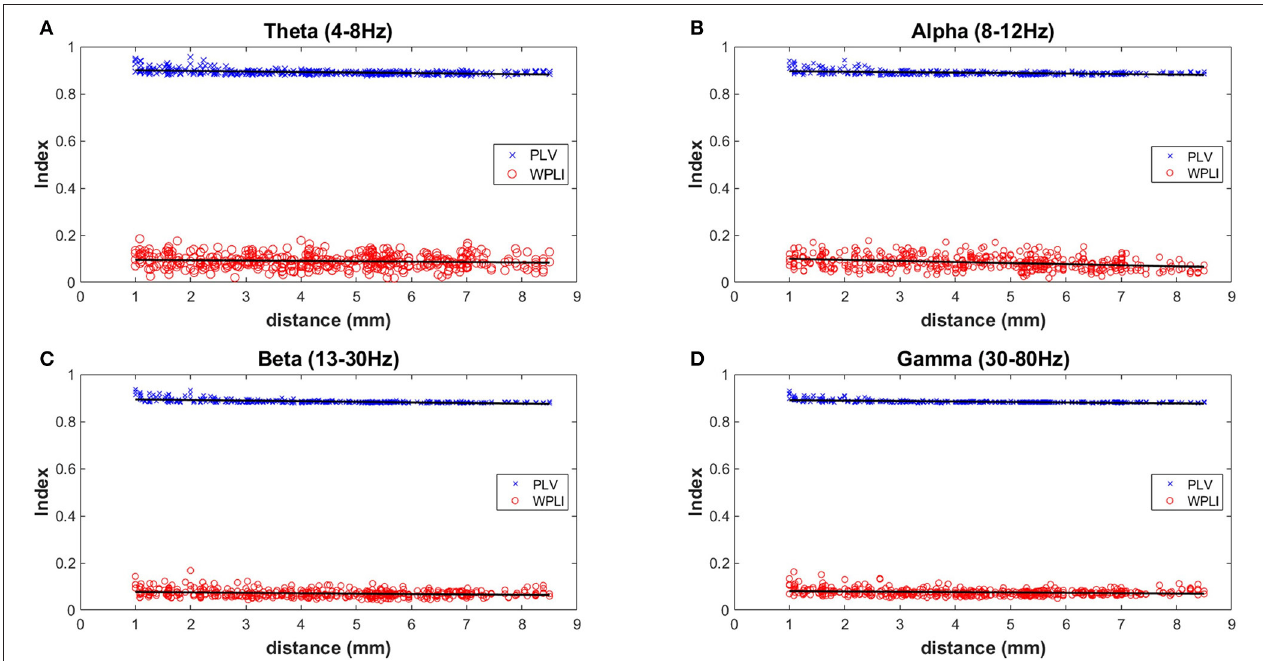
FIGURE 6 | Measures of inter-electrode synchrony across frequency bands and distance. Two measures of synchrony were calculated for each unique electrode pair (435 pairs) across 4 different frequency bands during wakefulness ( n = 5 mice). Analysis was done on 4 different frequency bands and the mean values of all mice are plotted in (A) Theta (4–8Hz), (B) Alpha (8–12Hz), (C) Beta (13–30Hz), and (D) Gamma